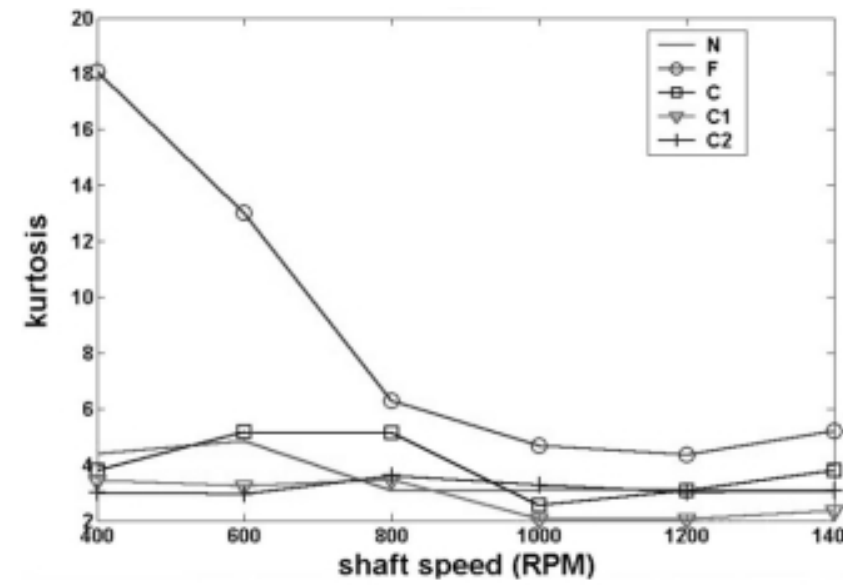
Fig. 3. Kurtosis of the acceleration signal as a function of the rotating shaft speed, load